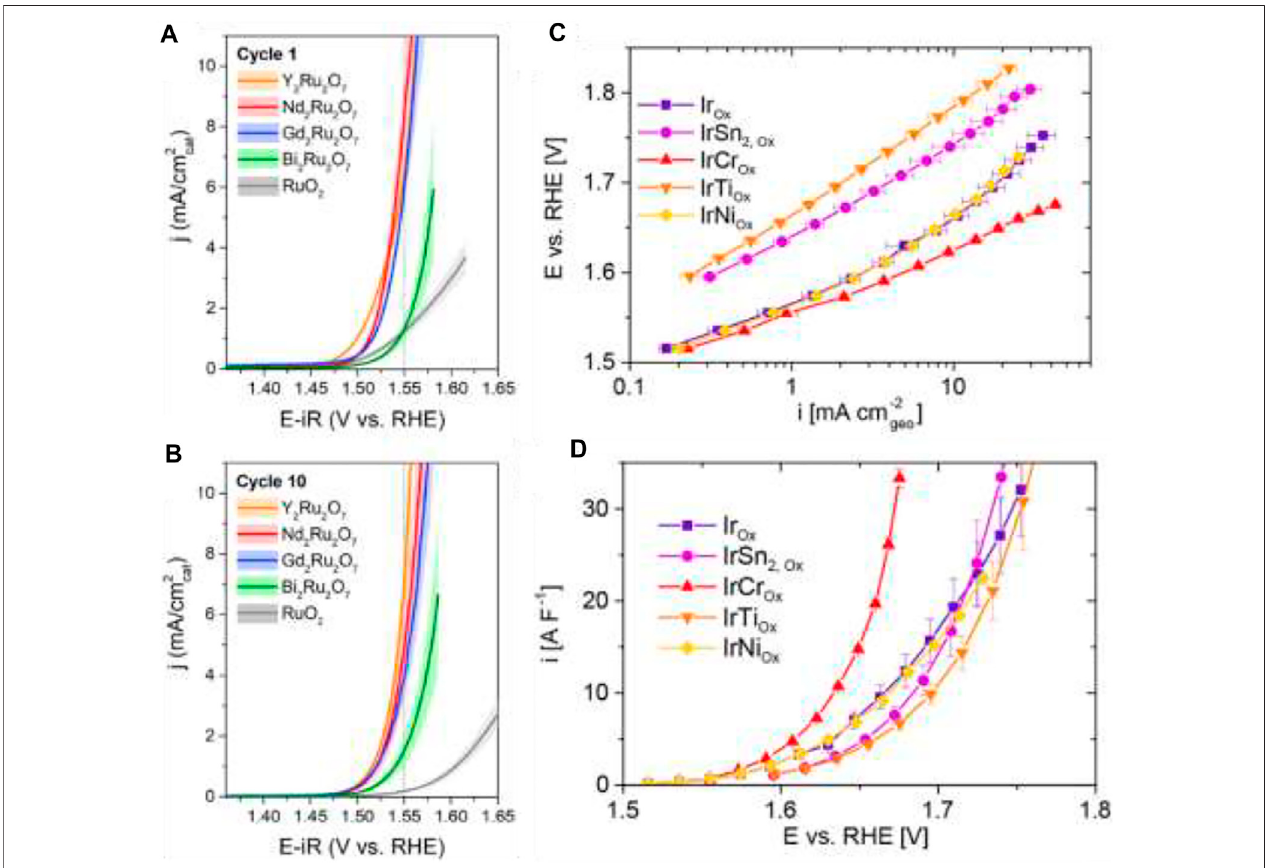
FIGURE 6 | Forward sweep of fi rst (A) and 10th (B) CV of ruthenium-based catalysts. Reprinted (adapted) with permission from Hubert et al. (2020). Copyright 2020 American Chemical Society. Electrochemical OER activity of electrochemically oxidized Ir, IrSn 2 , IrCr, IrTi, and IrNi in 0.5 M H 2 SO 4 . (C) Geometric current density Tafel plot. (D) DLC-normalized speci fi c activity. Reprinted (adapted) with permission from Strickler et al. (2019). Copyright 2019 American Chemical Society.